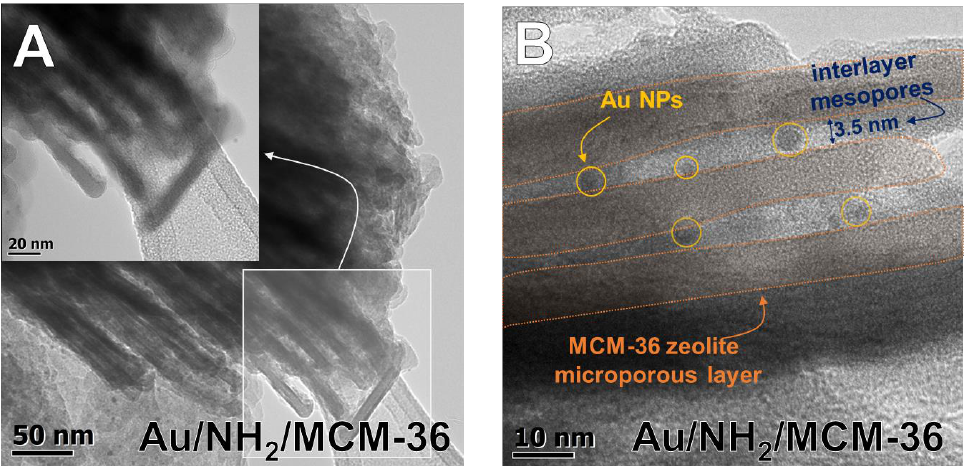
Figure 3. ( A ) An exemplary HR-TEM image indicating layered structure of MCM-36 support; ( B ) HR-TEM image presenting Au NPs location in interlayer spaces of MCM-36 support.